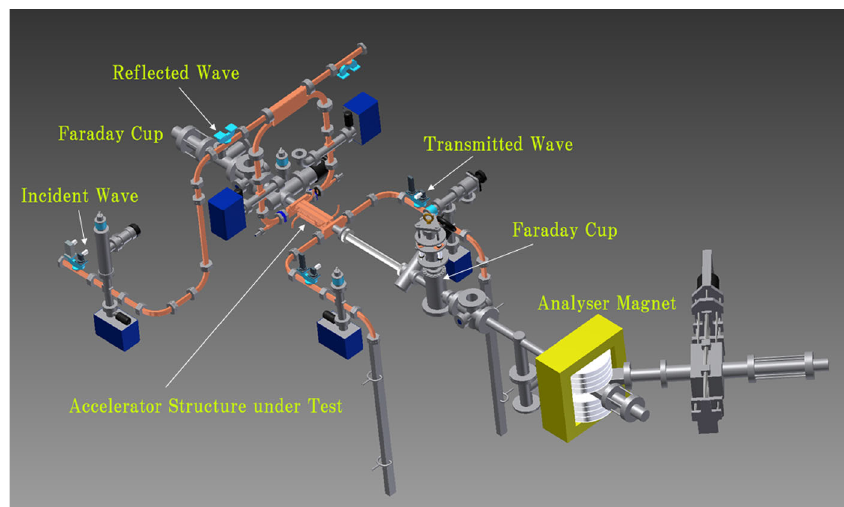
FIG. 4. Nextef accelerator testing setup. The incident, reflected, and transmitted waves are all measured by directional couplers. The waveguide distance from the structure input coupler to the directional coupler for the incident wave is approximately 2.2 m. The distances from the structure beam pipe flange to the Faraday cups (i.e., Faraday cup UP and Faraday cup DN) are both 0.8